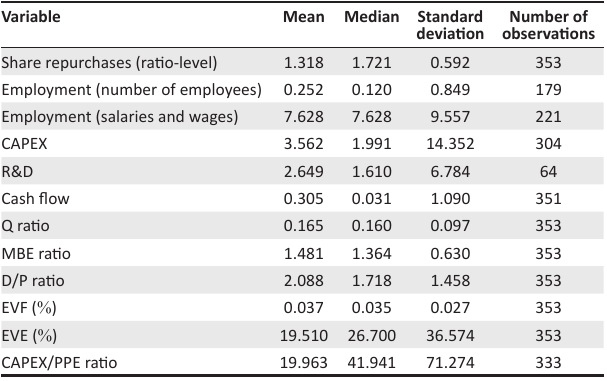
TABLE 1-A2: Descriptive statistics on study population.